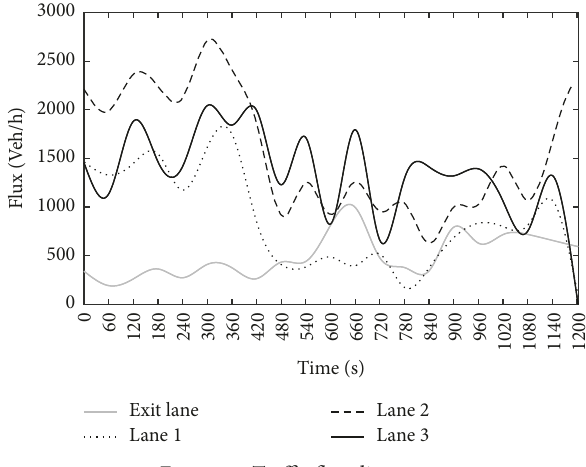
Figure 7: Traffic flux